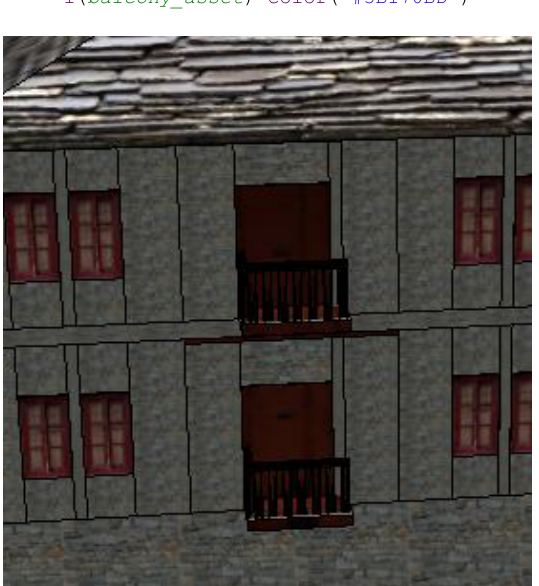
Figure 9. Detail of generated wooden